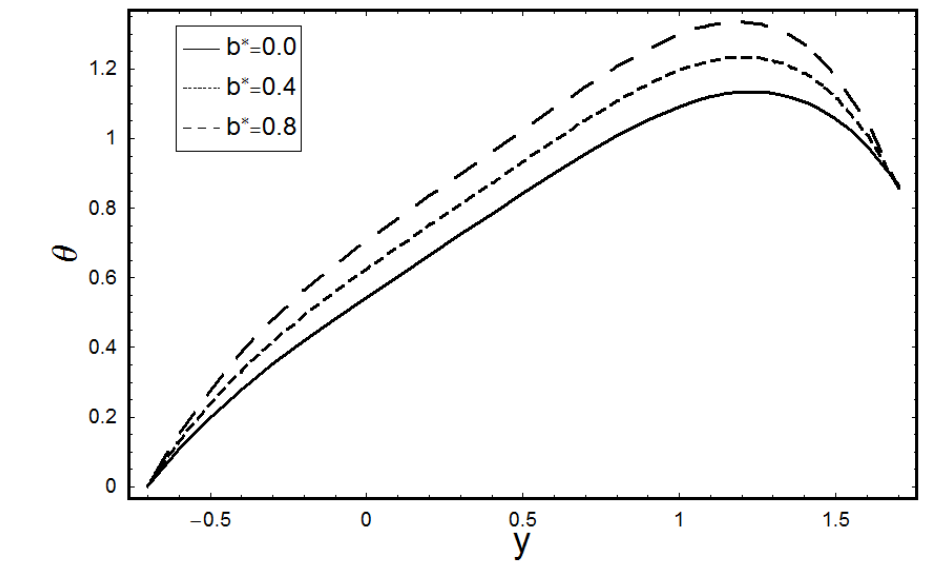
Figure 10. Variation in θ for b ∗ with a = 0.3, b = 0.3, d = 0.6, φ = π /4, Θ = 1, x = 0, n = 1.5, Br = 0.5, Bi 1 = 1 and Bi 2 = 10.